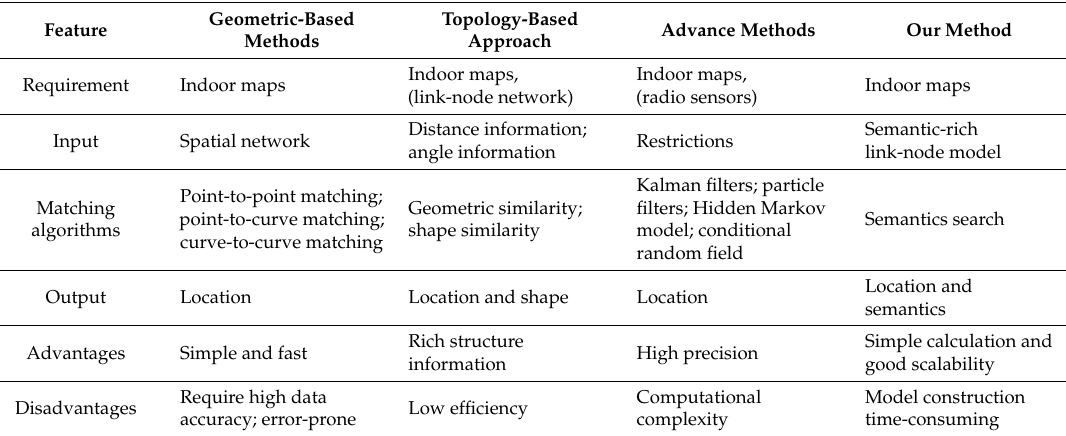
Table 3. Comparison of matching